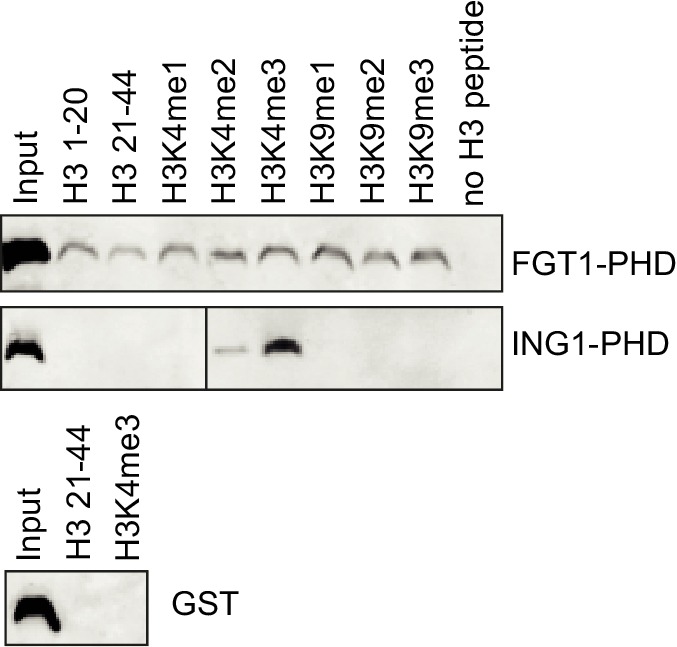
The PHD domain of FGT1 binds to histone H3 in vitro.Recombinant FGT1PHD-GST was immunoprecipitated with Flag-tagged histone peptides and detected by anti-GST immunoblotting. ING1PHD-GST and GST were used as controls.